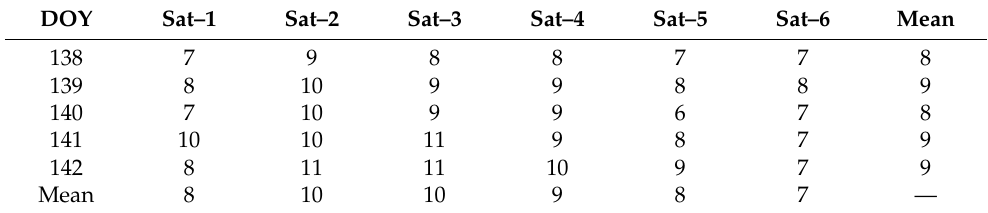
Table 3. Cycle slip ratio of observation of COSMIC-2, DOY 138–142, 2021. DOY Sat–1 Sat–2 Sat–3 Sat–4 Sat–5 Sat–6